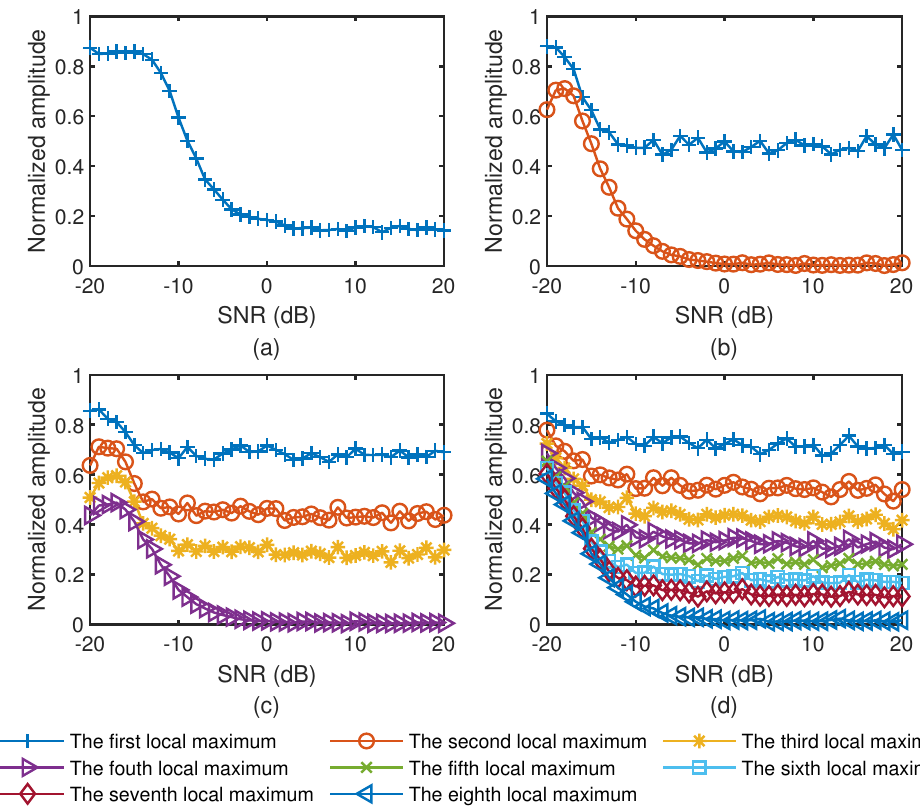
Figure 10. The variation of the extracted local maximum with the increase of the SNR. ( a ) OFDM, ( b ) 2FSK, ( c ) 4FSK, and ( d )